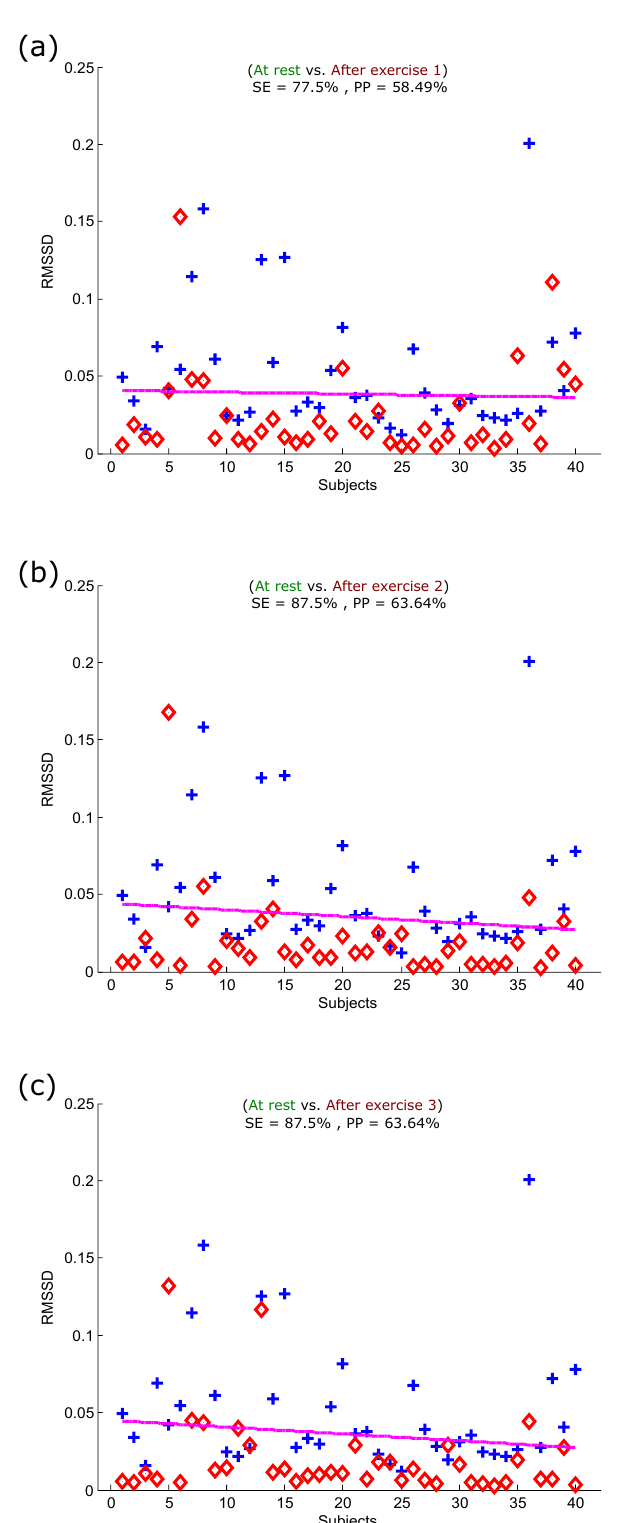
Figure 7. Linear classification of PPG signals measured before and after the simulated heat stress induction based on the RMSSD. ( a ) At rest vs. after exercise 1; ( b ) at rest vs. after exercise 2; ( c ) at rest vs. after exercise 3. Here, RMSSD stands for the square root of the mean of the squares of the successive aa (heartbeats) intervals; SE stands for sensitivity; and PP stands for positive predictivity. The plus signs refer to subjects measured at rest, while the diamond signs refer to subjects measured after the simulated heat stress